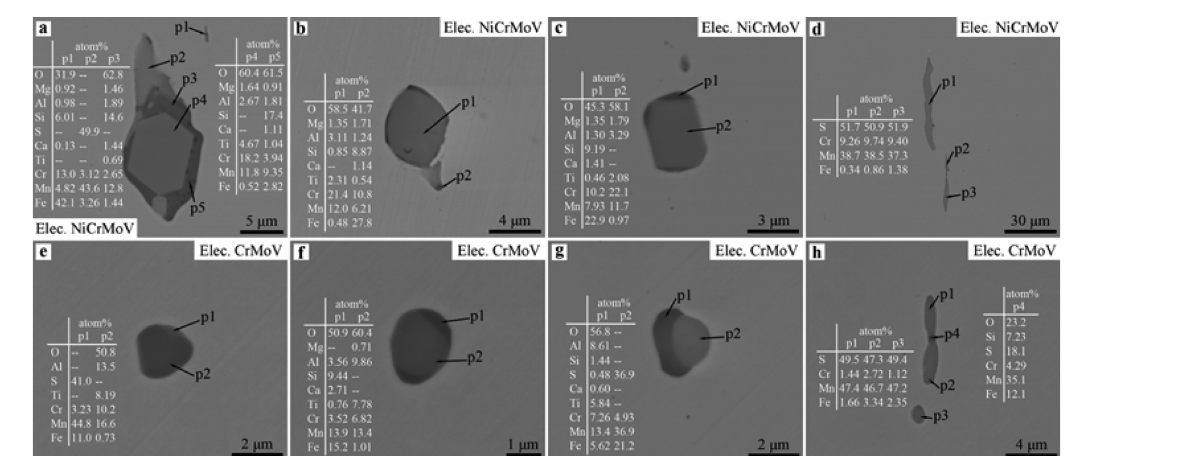
Figure 5: SEM images of typical inclusions observed in consumable electrodes: (a-d) specimen Elec. NiCrMoV, (e-h) specimen Elec.